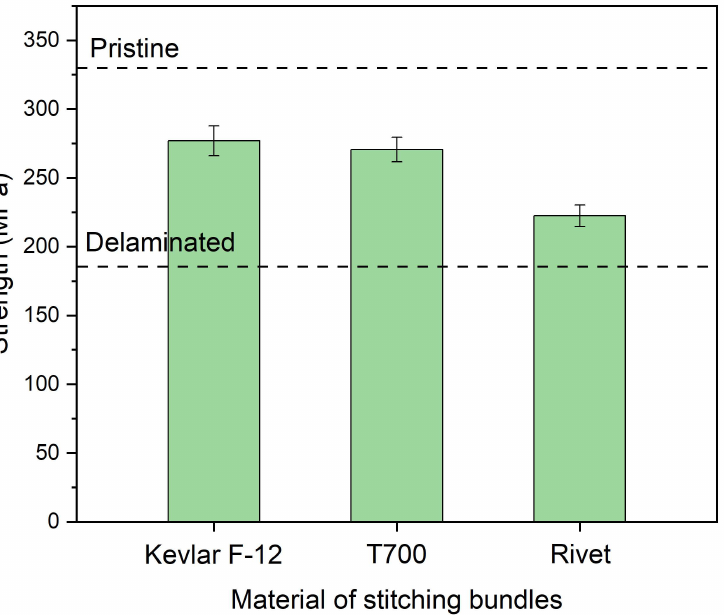
Figure 16. Strength of plates stitched by Kevlar F-12 bundles, T700 fiber bundles, and aluminum rivets with the parameters w = 0.8, d = 2.5, and n =